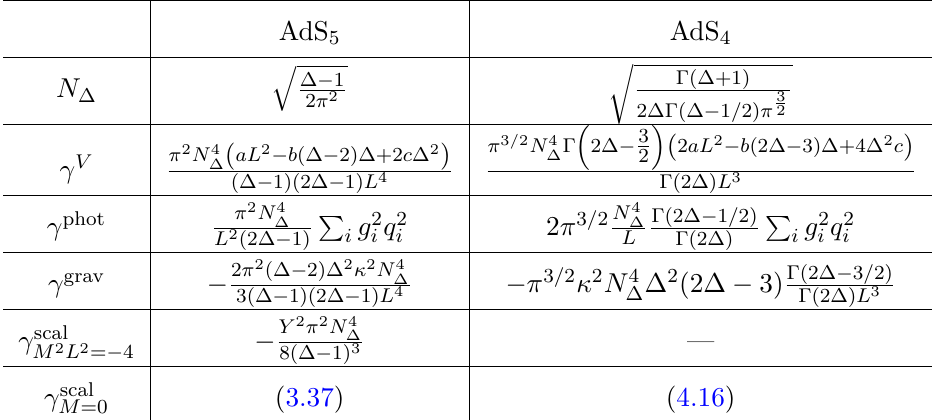
Table 1 . Table showing the contributions to the total binding energy, as given by (1.4), for the contact terms, the photon and the graviton. The scalar contribution in AdS of the scalar mass saturating the BF bound is also presented. The massless cases are referred to through equations in the main text. The first row gives the normalization factor N used in the binding energy expressions. Γ denotes the Gamma function. Photon contributions are always repulsive (within the unitarity bounds ∆ > 1 , ∆ > 1 / 2 in d = 5 , 4 respectively). The gravitational contribution is attractive, except in the intervals 1 < ∆ ≤ 2 in 5d and 3 in 4d where φ is tachyonic and gravity is repulsive. (Gravitational contributions vanish when the inequalities are saturated, while the lower bound is dictated either by unitarity or convergence of